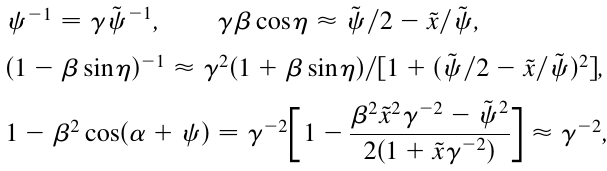
for x > 0 and (cid:2) ¼ s